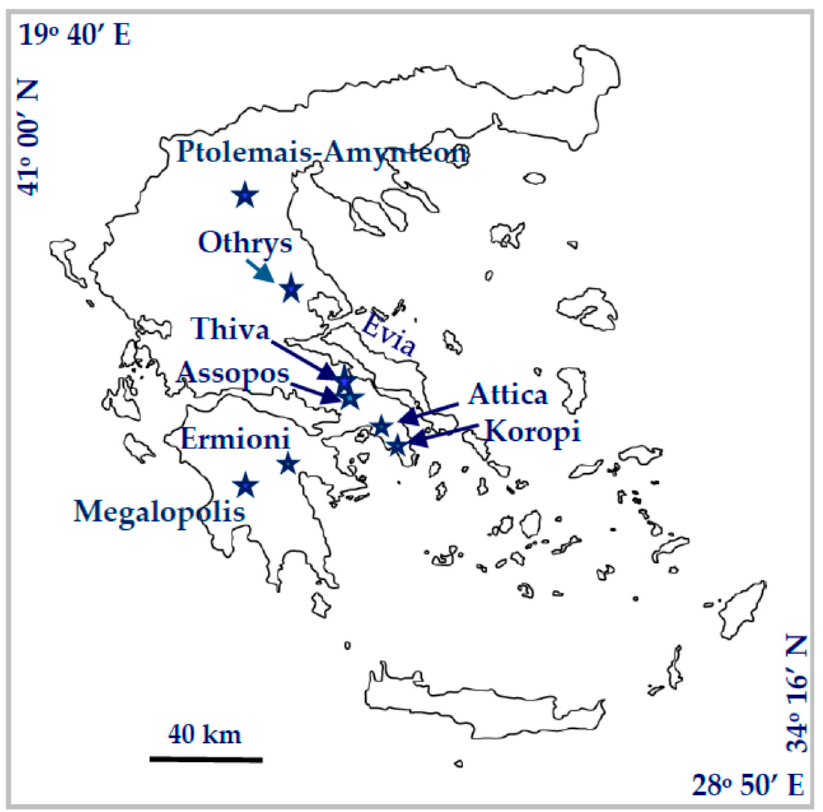
Figure 1. Sketch map of Greece showing the studied and other Se-bearing the locations.